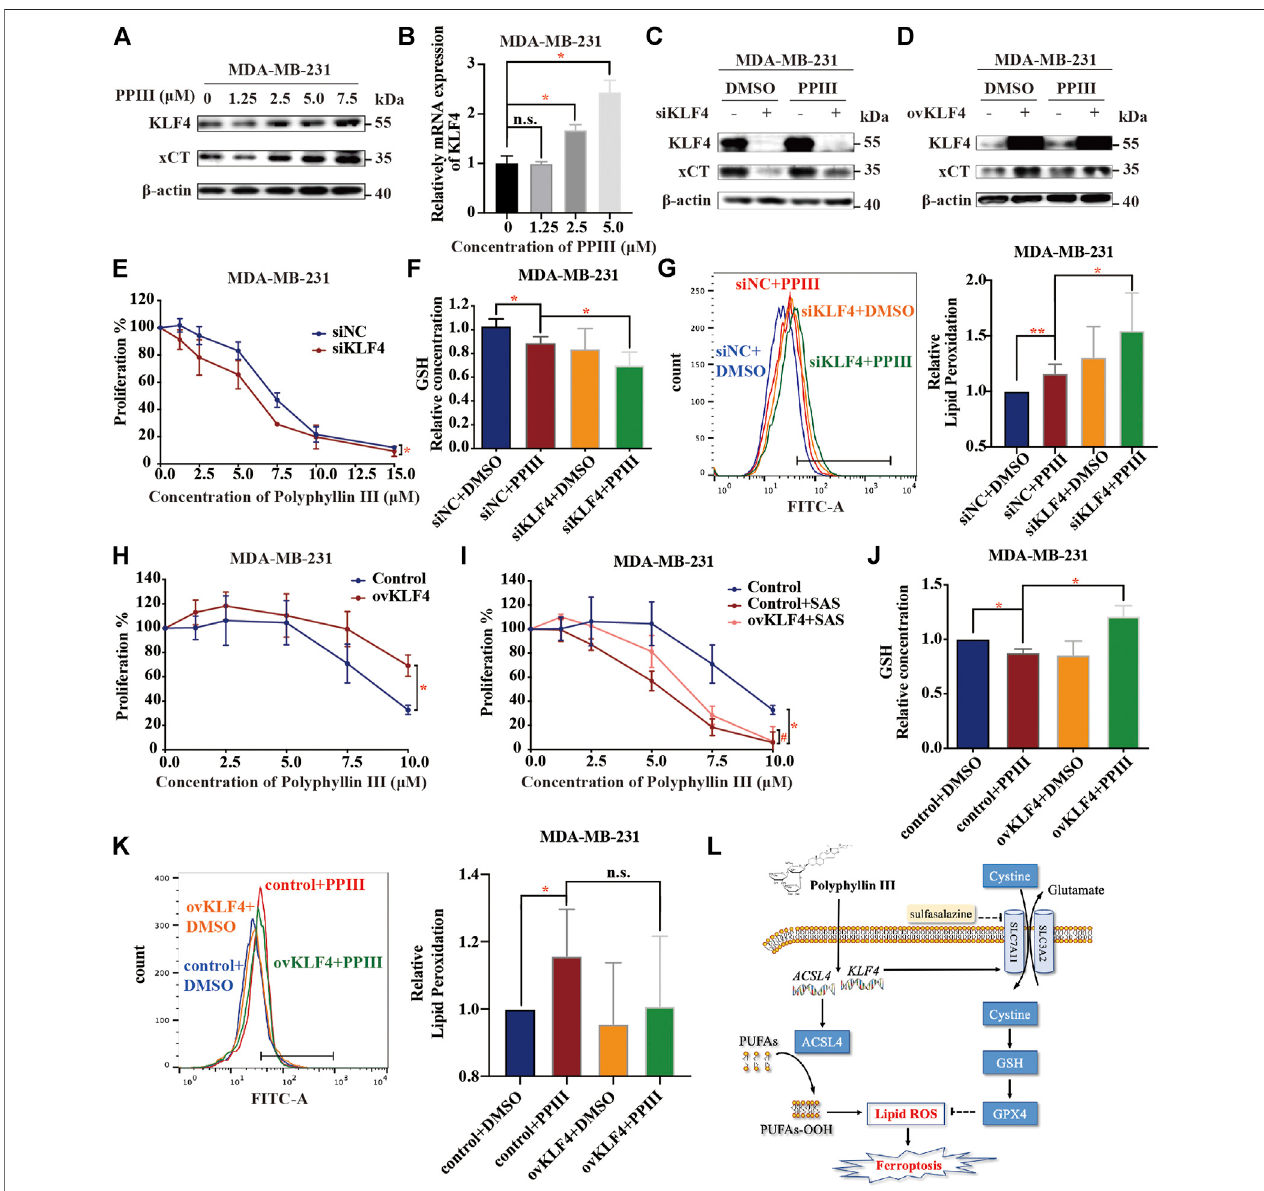
FIGURE5 | KLF4 is involved inPolyphyllin III-induced protective upregulationof xCT. (A) . Western blot analysisofKLF4and xCTexpression in MDA-MB-231 cells after Polyphyllin III (0 – 7.5 μ M) treatment for 24 h. (B) . qRT-PCR analysis of relative KLF4 mRNA expression after Polyphyllin III (0 – 5 μ M) treatment for 24 h. (C,D) . Western blot analysis of KLF4 and xCT expression after 5 μ M Polyphyllin III treatment for 24 h when transfected (C) with negative control siRNA (siNC) or KLF4 siRNA (siKLF4) and (D) with the control plasmid (Control) or KLF4 plasmid (ovKLF4). (E – G) . MDA-MB-231 cells were transfected with negative control siRNA (siNC) or KLF4 siRNA (siKLF4) and then treated with 5 μ M Polyphyllin III for 24 h. The error bars show the means ± SD, n (cid:2) 3 independent repeats, and p values were calculated usingatwo-tailedpairedStudent ’ st-testin(E)andatwo-tailedunpairedStudent ’ st-testin(F)and(G)(E)Thecellviabilitywasassayed(F)TherelativelevelsofGSHwere assayed (G) The relative levels of lipid peroxidation were assayed by C11-BODIPY fl uorescence. (H – K) . KLF4 was overexpressed using plasmid transfection in MDA- MB-231cells,andthenthecellsweretreatedwith5 μ MPolyphyllinIIIfor24 h.Theerrorbarsshowthemeans ± SD,n (cid:2) 3independentrepeats, p valueswerecalculated using a two-tailed paired Student ’ s t-test in (H) and (I) and a two-tailed unpaired Student ’ s t-test in (J) – (K) (H) The cell viability was assayed (I) The cells were treated with 5 μ M Polyphyllin III in the absence or presence of SAS for 24 h. The cell viability was assayed (J) The relative levels of GSH were assayed (K) The relative levels of lipid peroxidation were assayed by C11-BODIPY fl uorescence. (L) Schematic diagram of the mechanism of Polyphyllin III in MDA-MB-231 cells. * p < 0.05; ** p < 0.01; *** p < 0.001; n. s., not signi fi cant ( p > 0.05).